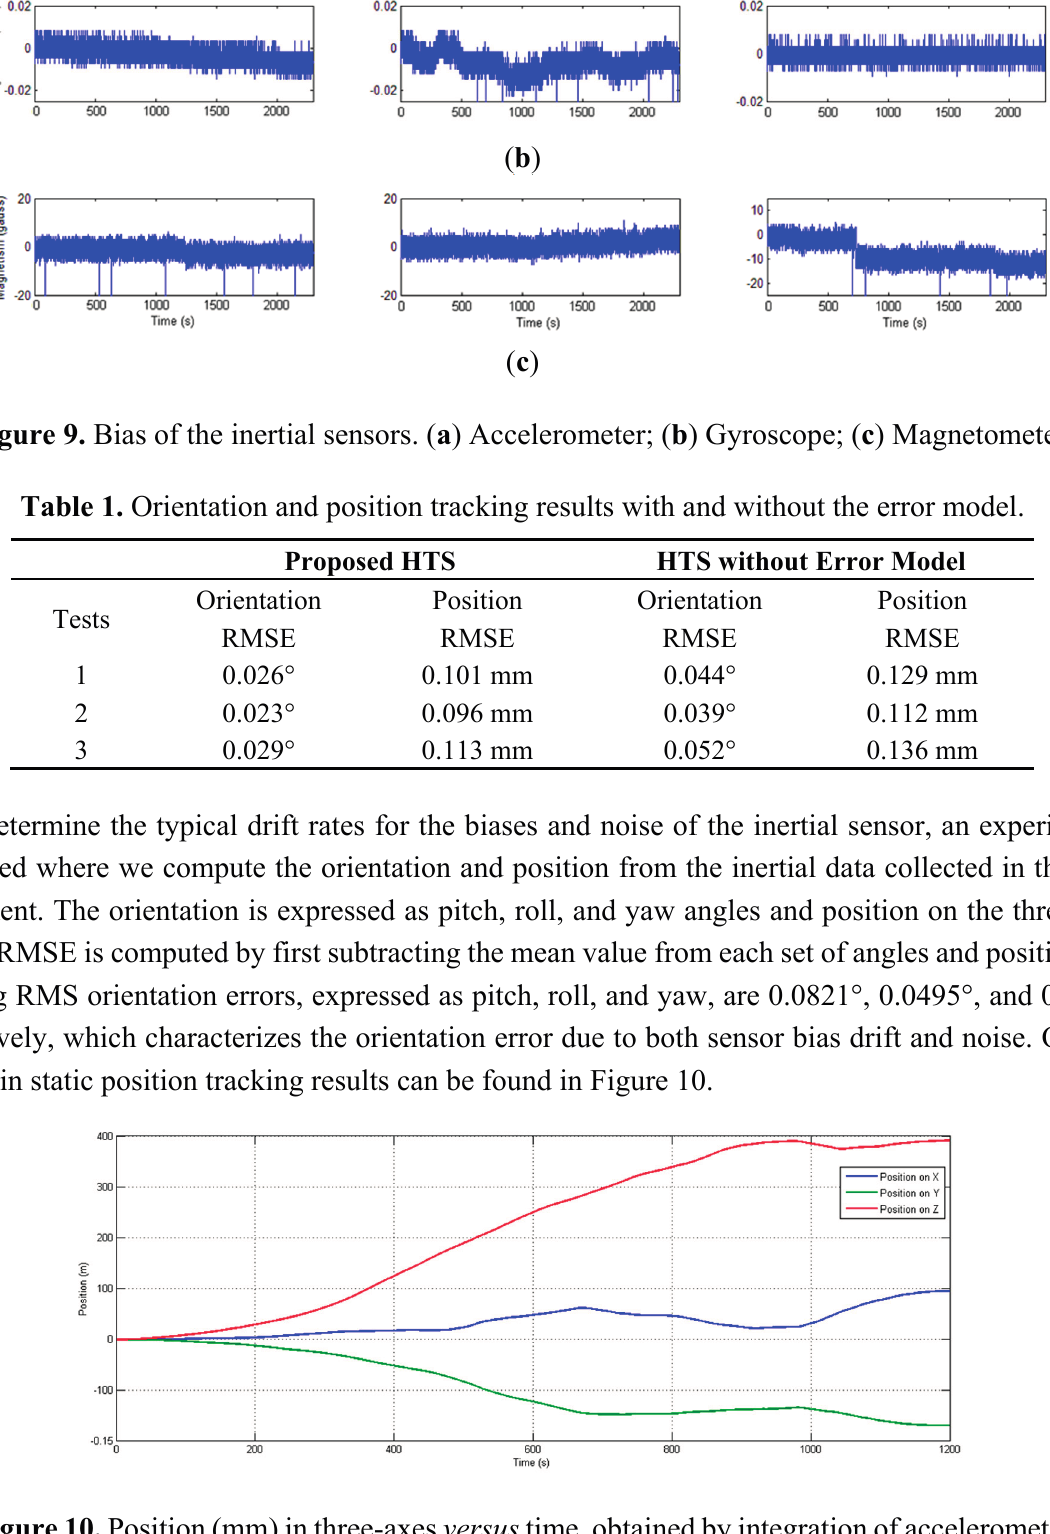
Figure 10. Position (mm) in three-axes versus time, obtained by integration of accelerometer data. As expected, results show large errors in position as time